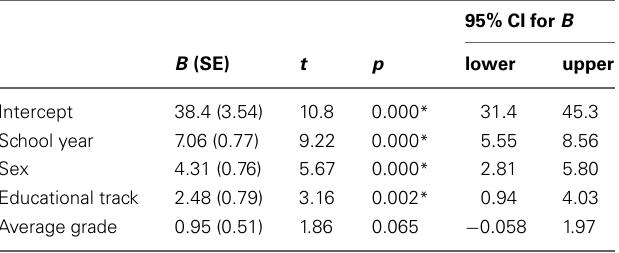
Table 3 | Predictors of LDST